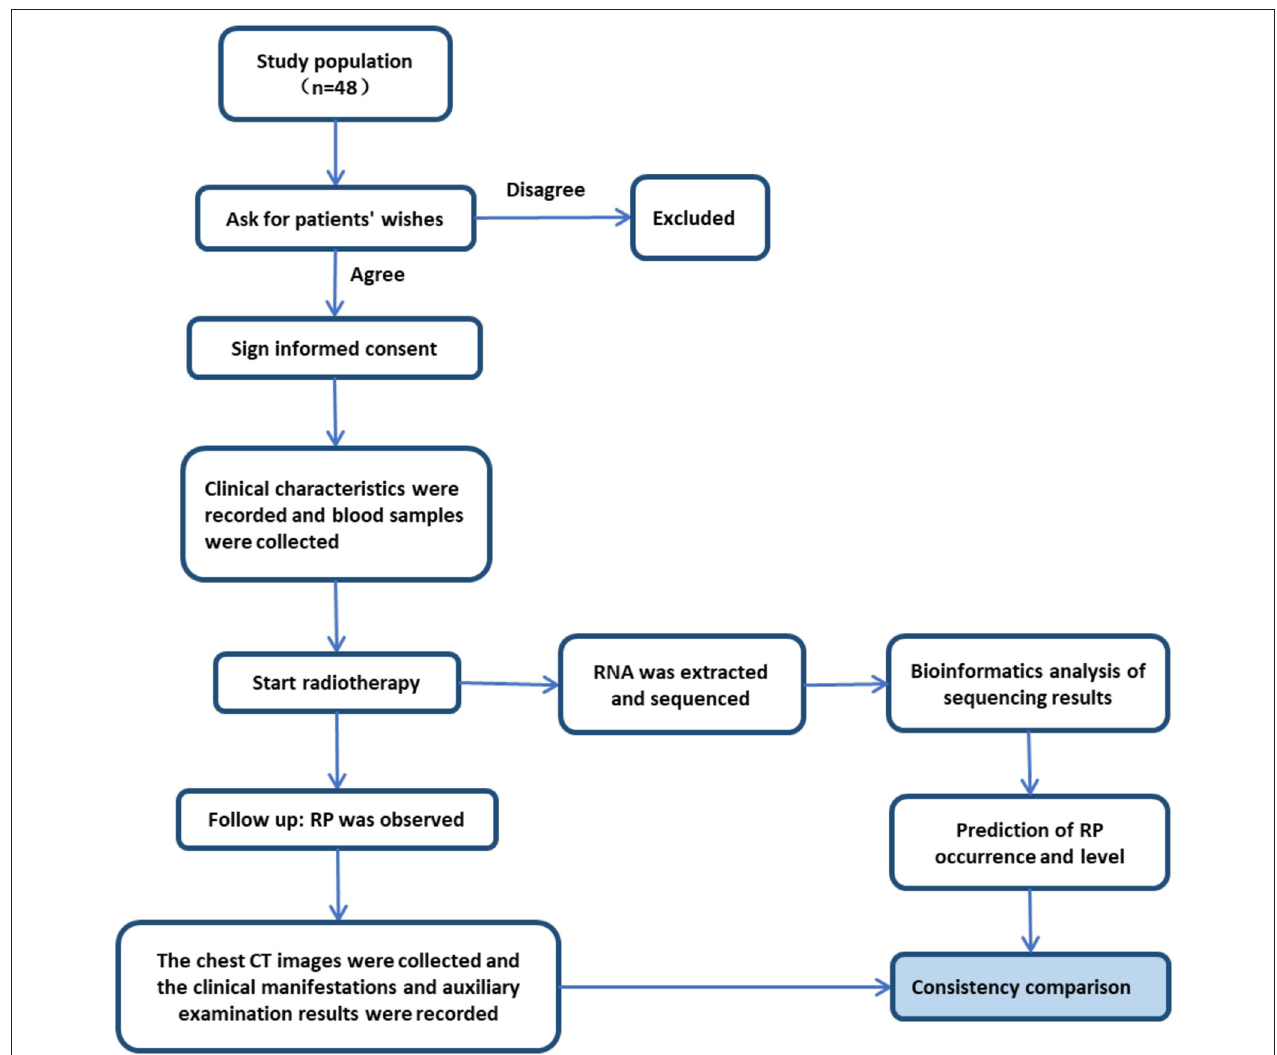
FIGURE 1 | Study design